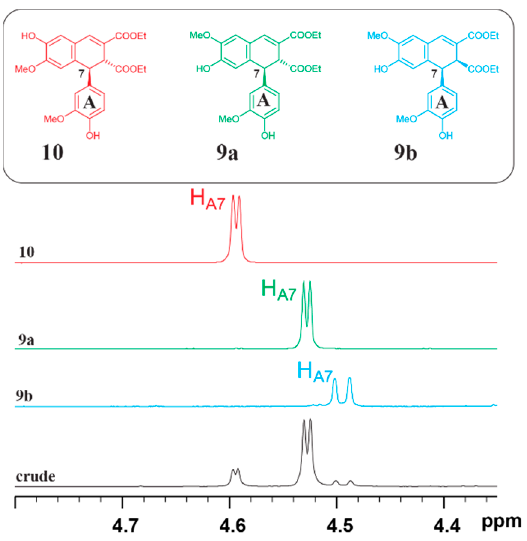
Figure 6. Partial 1 H NMR spectra showing the characteristic chemical shifts of A-7 protons in crude products from acid catalyzed transformation of FA dilactone and compounds 9 and 10 .